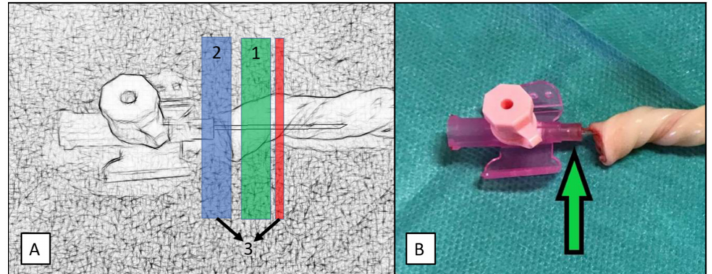
Figure 1. ( A ): Graphic illustration of the three different securement techniques (Secure 1–3): a human umbilical cord remnant was catheterized with a peripheral catheter. For Secure 1, a disposable umbilical clamp was closed in the area of the green box (1) at the level of the inserted transparent part of the catheter. For Secure 2 and Secure 3, a disposable umbilical clamp was closed in the area of the blue box (2) at the junction of the transparent catheter and the plastic wings. For Secure 3, an umbilical tape was additionally placed around the umbilical cord in the area of the red box at the level of the transparent catheter (3). ( B ): The green arrow indicates the junction of the transparent catheter and the colored plastic wings of a 20-gauge peripheral catheter. The disposable umbilical clamp was closed at the level of this junction in Secure 2 and Secure 3.